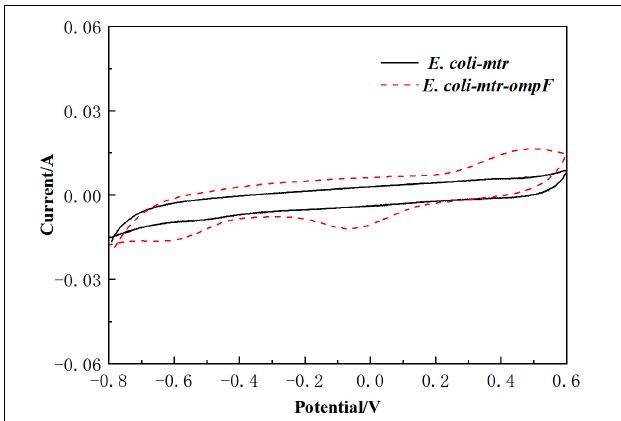
FIGURE 6 | CV analysis of E. coli-mtr and E. coli-mtr-ompF scanned from -800 to 600